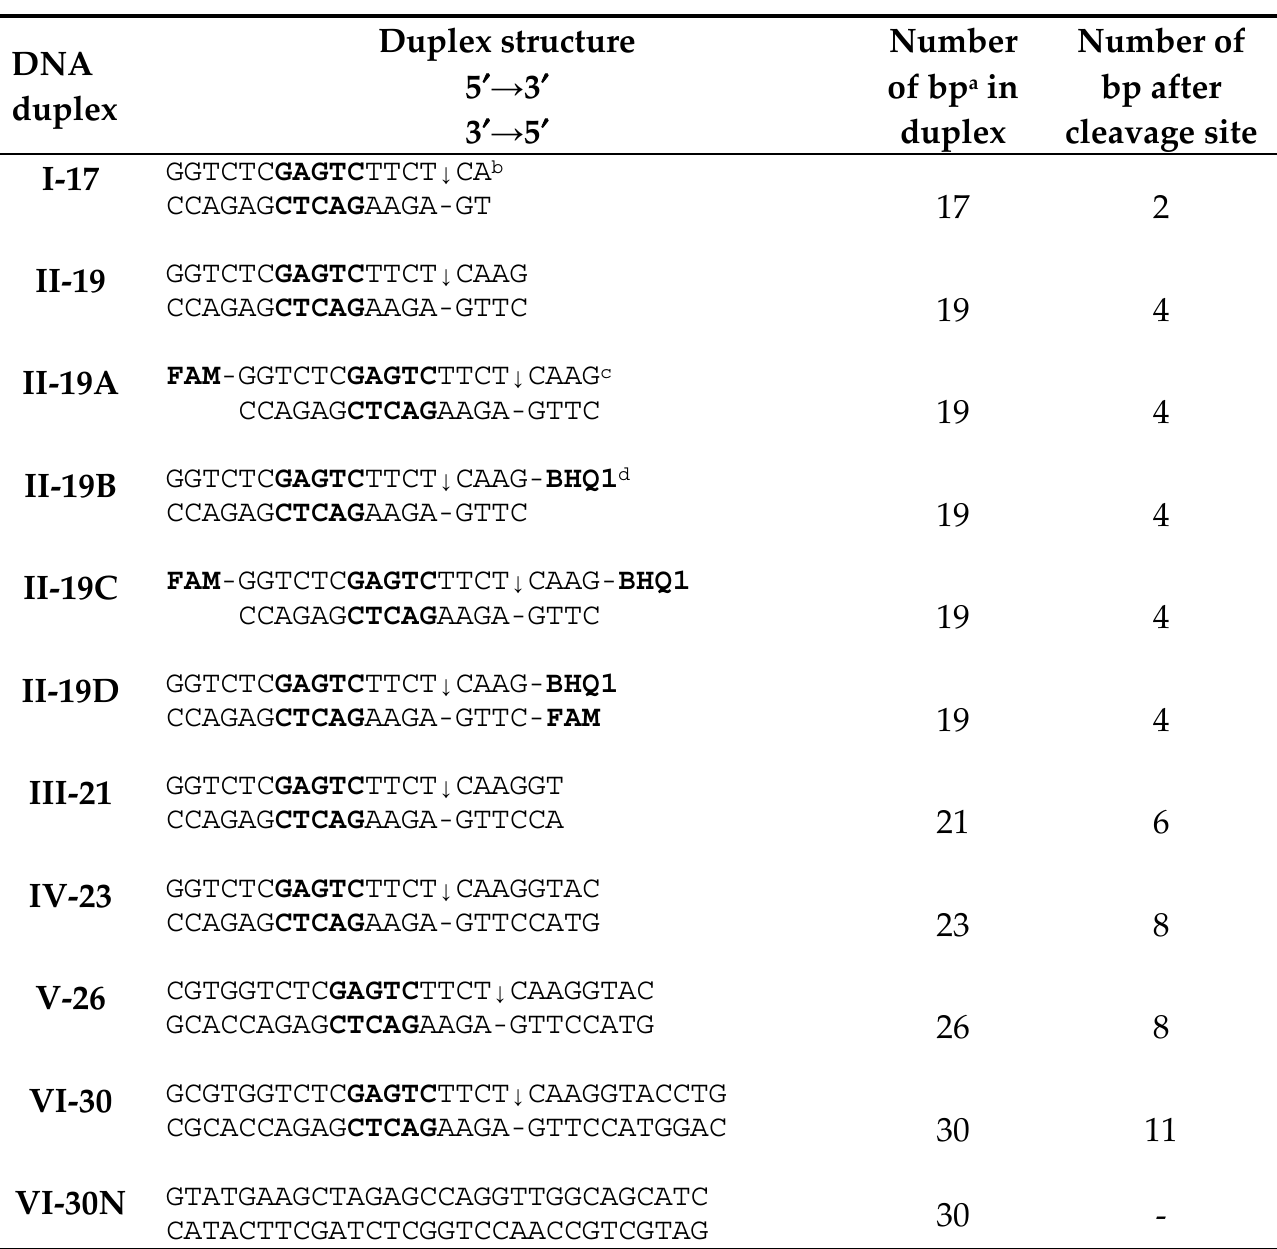
Table 1. DNA duplexes used in this